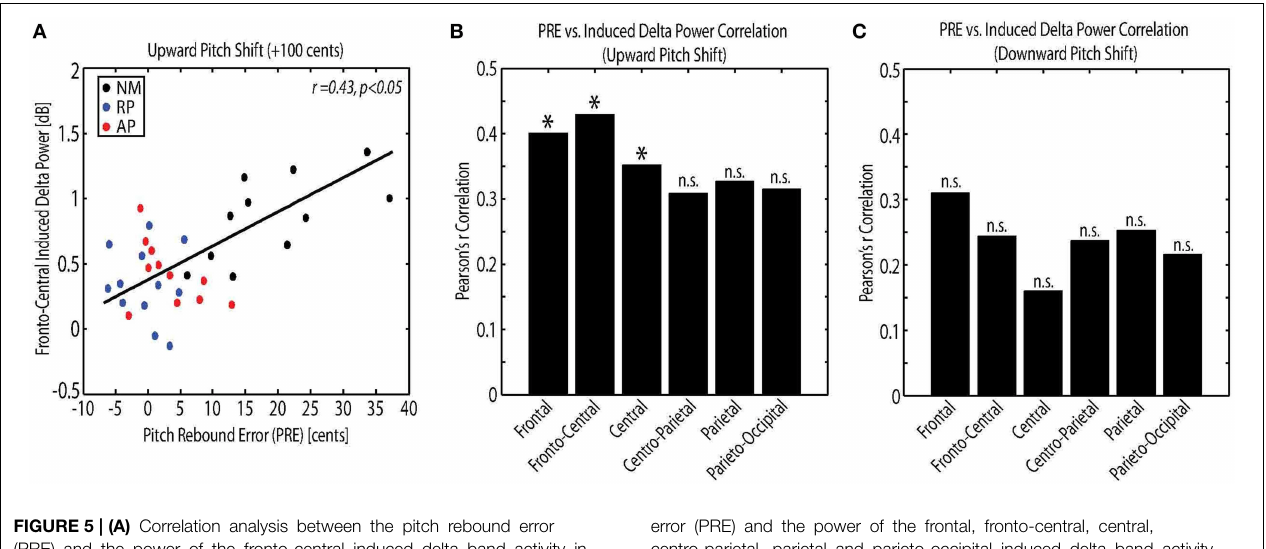
FIGURE 5 | (A) Correlation analysis between the pitch rebound error (PRE) and the power of the fronto-central induced delta band activity in response to upward pitch shift stimulus across non-musicians (NM), relative pitch (RP), and absolute pitch (AP) musicians. Bar plot representation of the correlation analysis between the pitch rebound